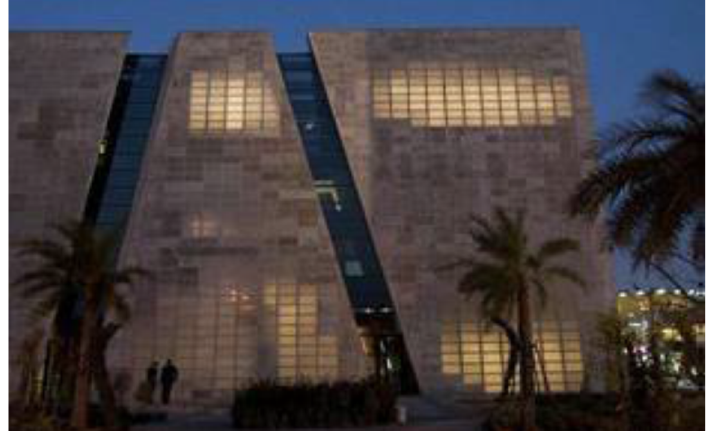
Figure 3. Application of LTC in Italian Pavilion [2,76].